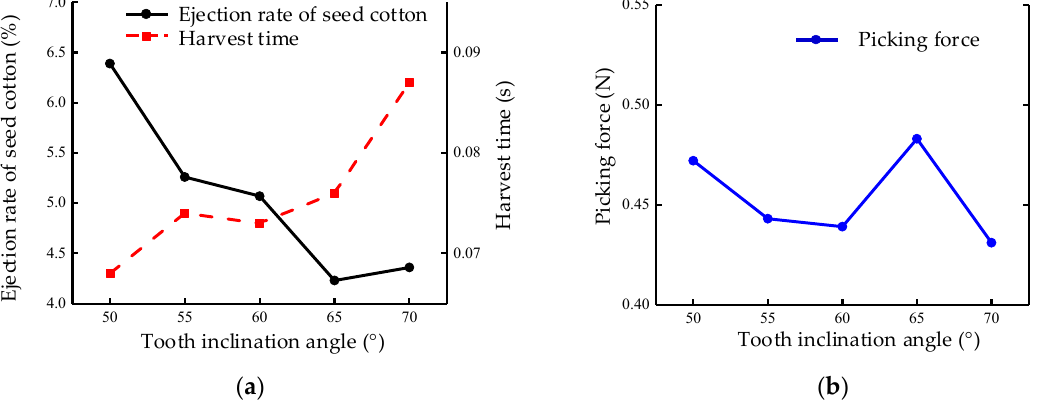
Figure 13. Effect of the tooth anterior angle on the picking performance of the spindle: ( a ) before the tooth angle (ejection rate of seed cotton and harvest time), ( b ) before the tooth angle (picking force).